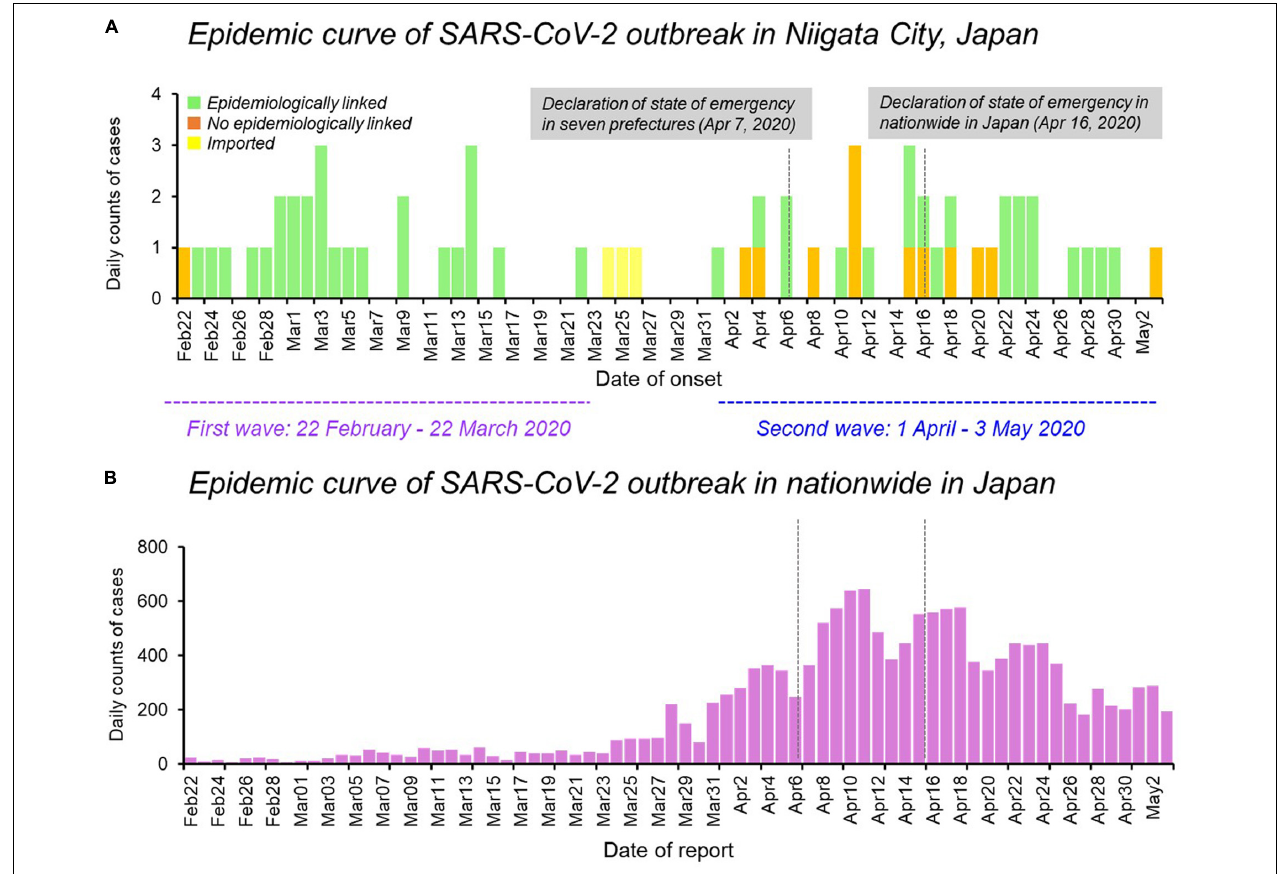
FIGURE 1 | Epidemiological dynamics of SARS-CoV-2 Niigata City and nationwide in Japan. (A) Epidemic curve of daily cases of laboratory-confirmed SARS-CoV-2 infection in Niigata City, Japan, by symptom onset date and colored as per epidemiological linkage, between 22 February and May 03, 2020 ( n = 63). (B) Epidemic curve of daily cases of laboratory-confirmed SARS-CoV-2 infection in nationwide in Japan, by reporting date and colored as purple, between 22 February and May 03, 2020 ( n = 14,915). The purple dotted line represents the first wave by the date of onset (between 29 February and March 22, 2020) and the light blue dotted line represents the second wave by the date of onset (between 01 April and May 03, 2020). Data on the daily number of new confirmed cases in nationwide in Japan were retrieved from the website of the Ministry of Health, Labour and Welfare, Japan